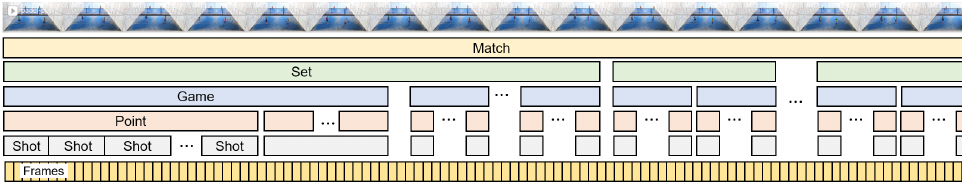
Figure 2. Feature diagram of a video-recorded padel match.